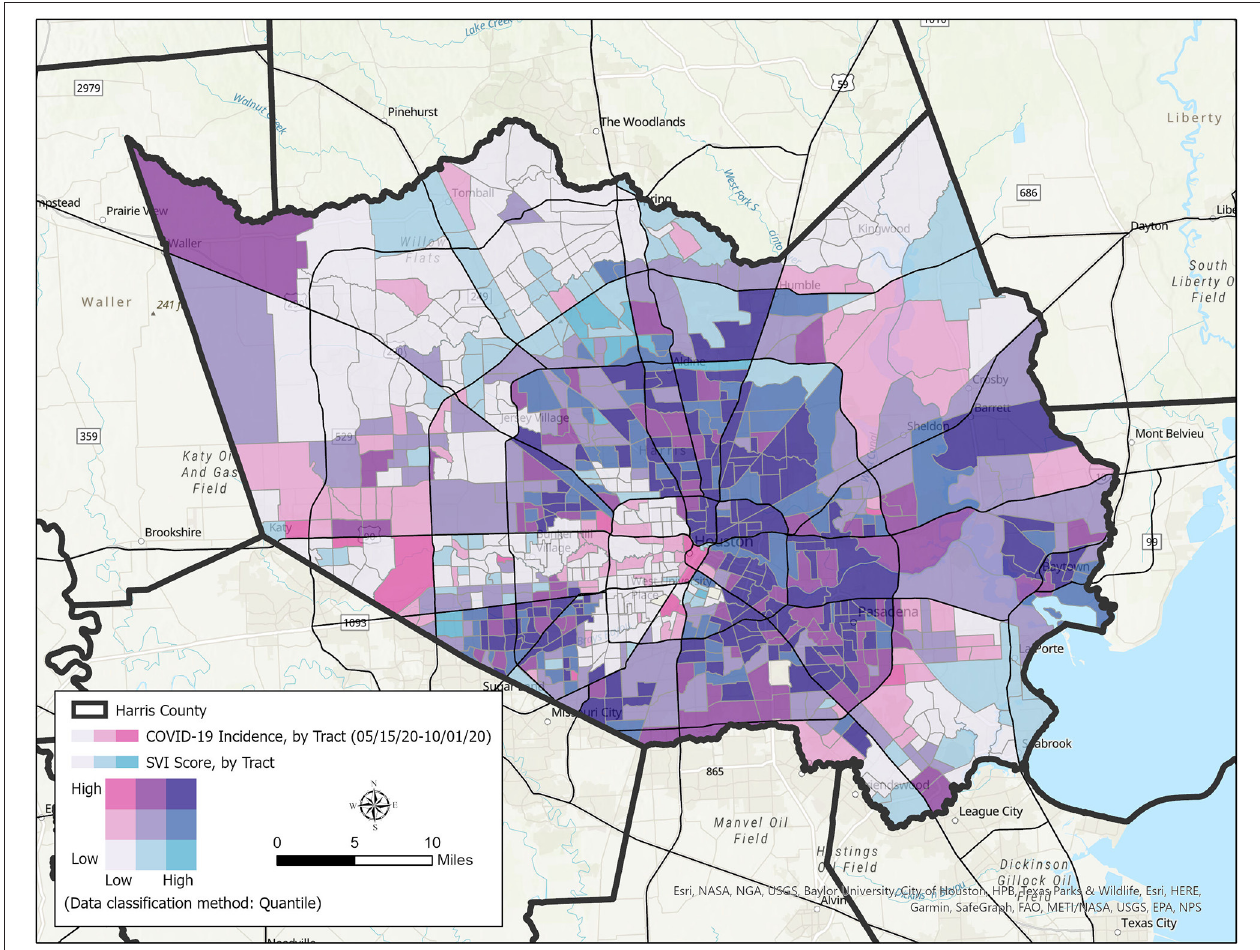
FIGURE 1 | Bivariate map of SARS-CoV-2 incidence and social vulnerability